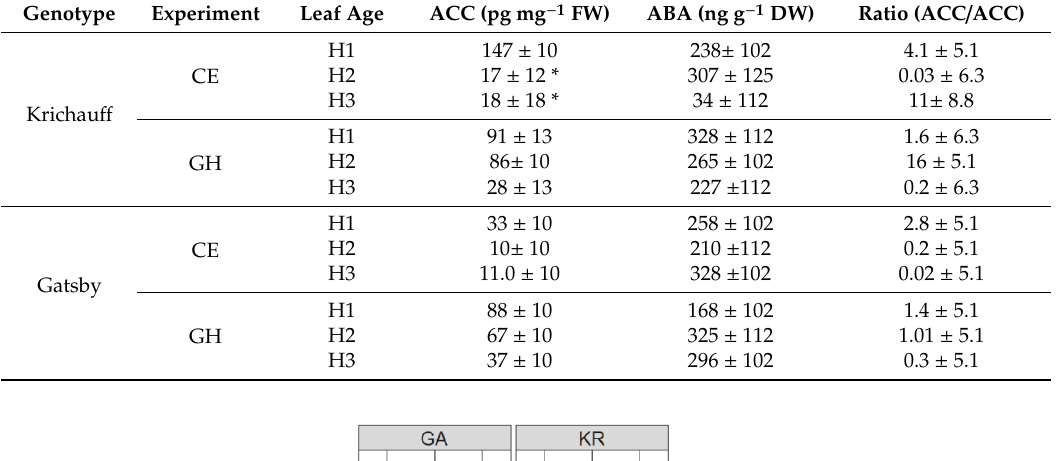
Table 1. Mean values of 1-aminocyclopropane-1-carboxylic acid (ACC) and abscisic acid (ABA) concentrations, and their ratio in leaves of two wheat cultivars (KR, Krichauff; GA, Gatsby) grown in the glasshouse (GH) or controlled environment (CE) chamber. Asterisks indicate significant difference from H1 in the relevant experiment and genotype. Samples were collected after completing gas exchange measurements of young expanding (H1-21 DAS), fully expanded (H2-28 DAS) and mature (H3-35 DAS) leaves. Values represent the means ± standard errors of 3 – 6 biological replicates. Genotype